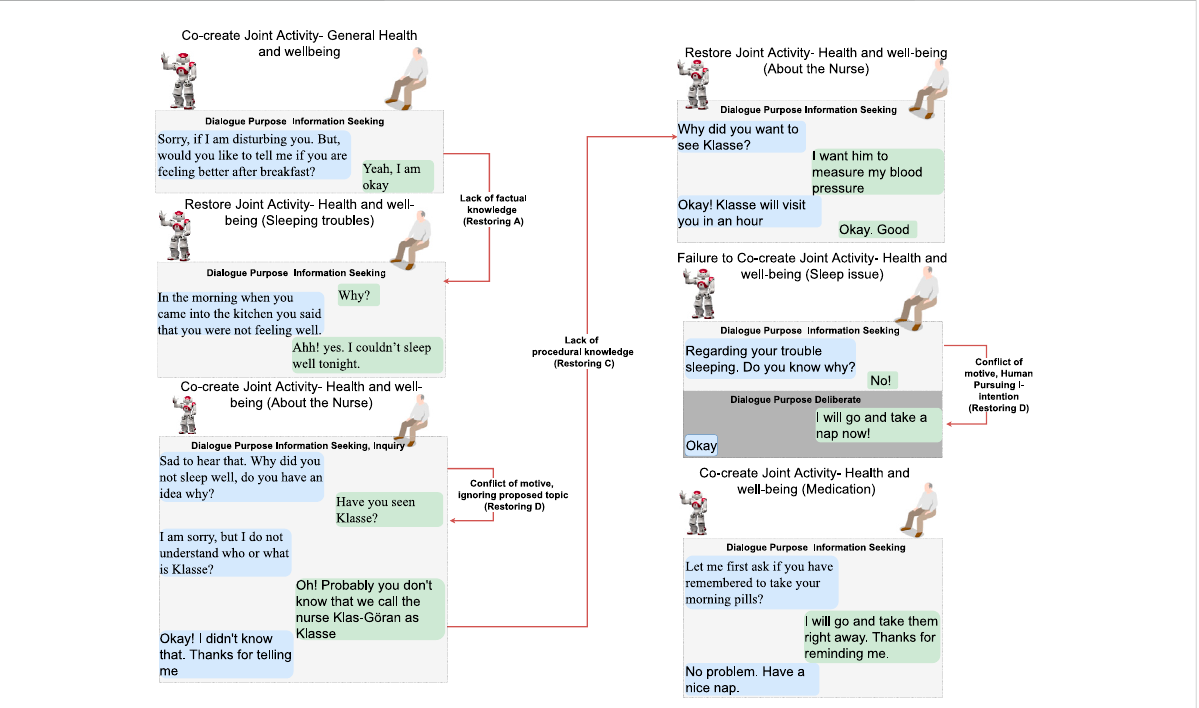
FIGURE 6 Scenario 3b — R follows up on the H ’ s well-being since (s) he indicated earlier during the day that he/she was not feeling well. The dialogue unfolds into co-construction ofjointactivity aboutgeneralhealthand well-being and medication,mediation to knowthewhereaboutsof thenurse, and restoration from con fl icting motives, lack of factual and procedural knowledge ( restoring D , A , C , refer to Figure 2). Text highlighted in blue represents R ’ s utterances, and text in green is H ’ s